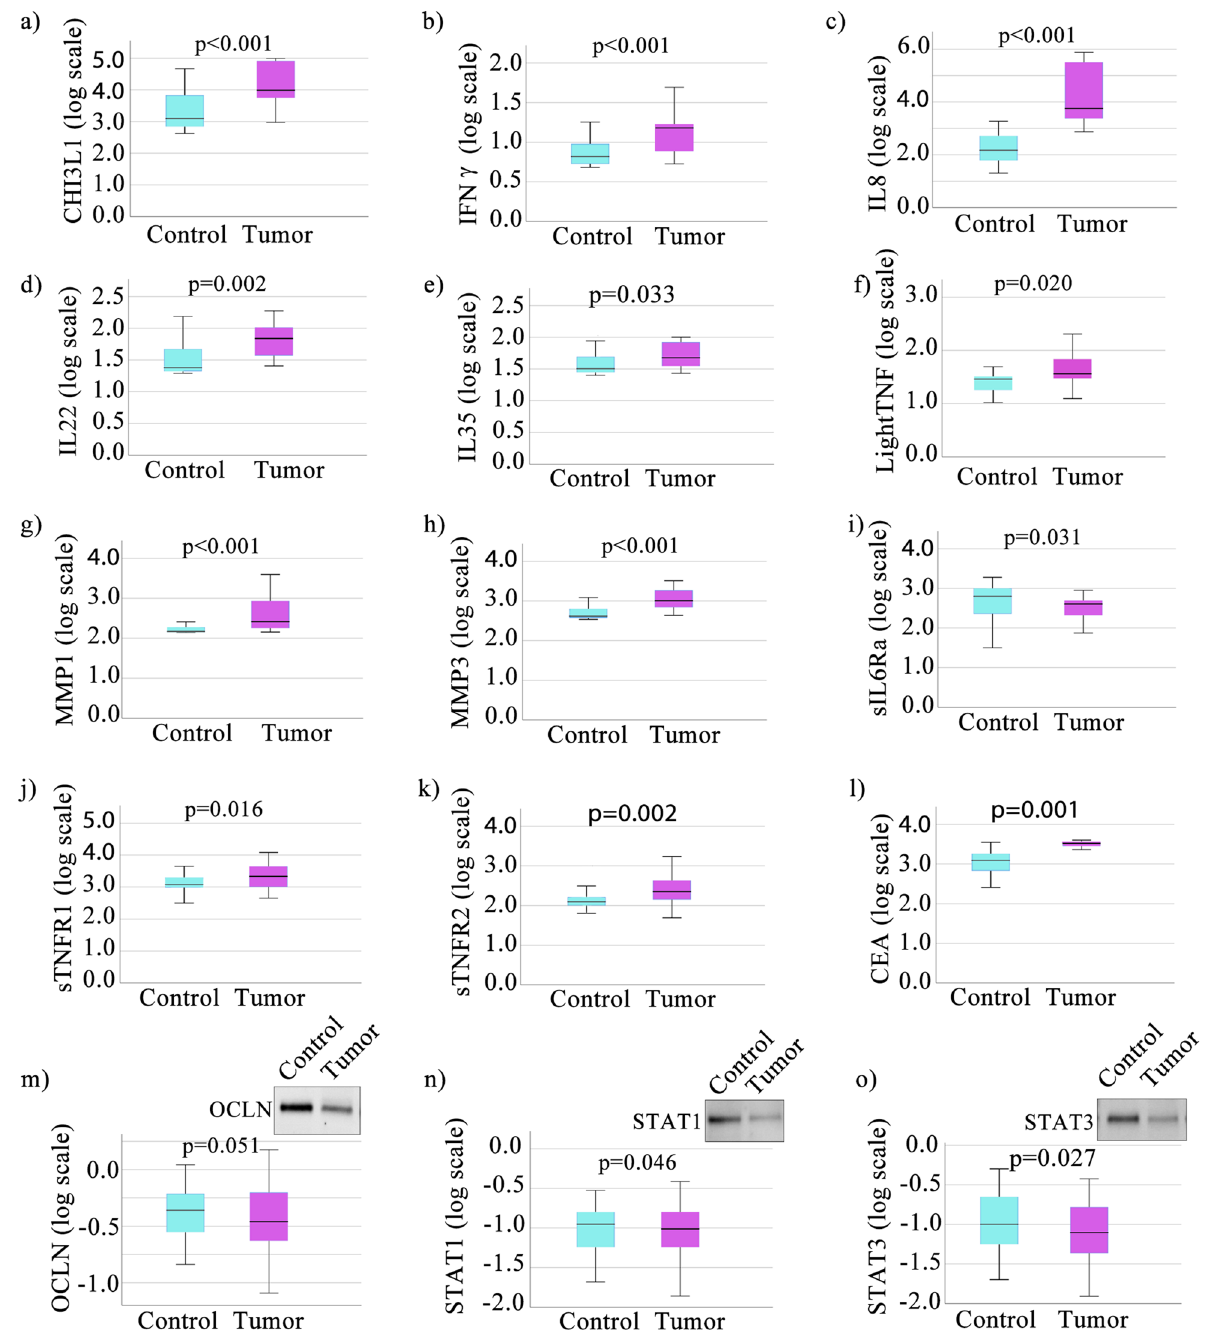
Figure 2. Box-plots of log-transformed biomarker levels in tumor and paired normal tissue samples. Selected log-transformed biomarker values did not exibit normal distribution. ( a ) CHI3L1; ( b ) IFN γ; ( c ) IL8; ( d ) IL22; ( e ) IL35; ( f ) Light TNF; ( g ) MMP1; ( h ) MMP3; ( i ) sIL6Rα; ( j ) sTNFR1; ( k ) sTNFR2; ( l ) CEA; ( m ) OCLN; ( n ) STAT1; ( o ) STAT3; in box-plots ( m ), ( n ), ( o ) the source data was the average relative density of immunoblot bands of all tumor and paired normal tissue samples; the cropped inserts show representative immunoblot examples for OCLN, STAT1, STAT3, The original immunoblots are available in Supplementary Figures S2, S3 and S4; p values resulting from comparison of control and tumor means of log-transformed concentration values through the Wilcoxon test are written above each boxplot